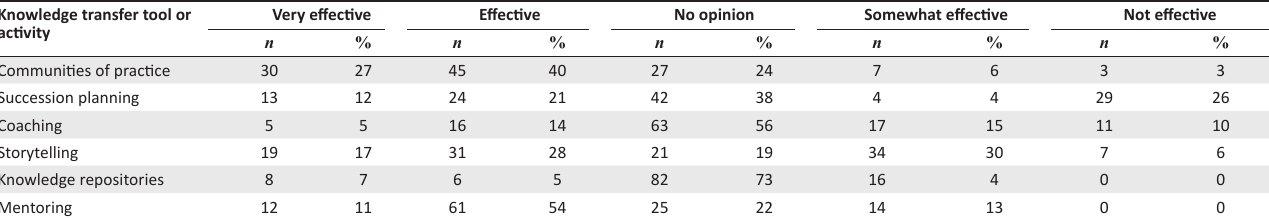
TABLE 1: Effectiveness of knowledge transfer activities ( N =